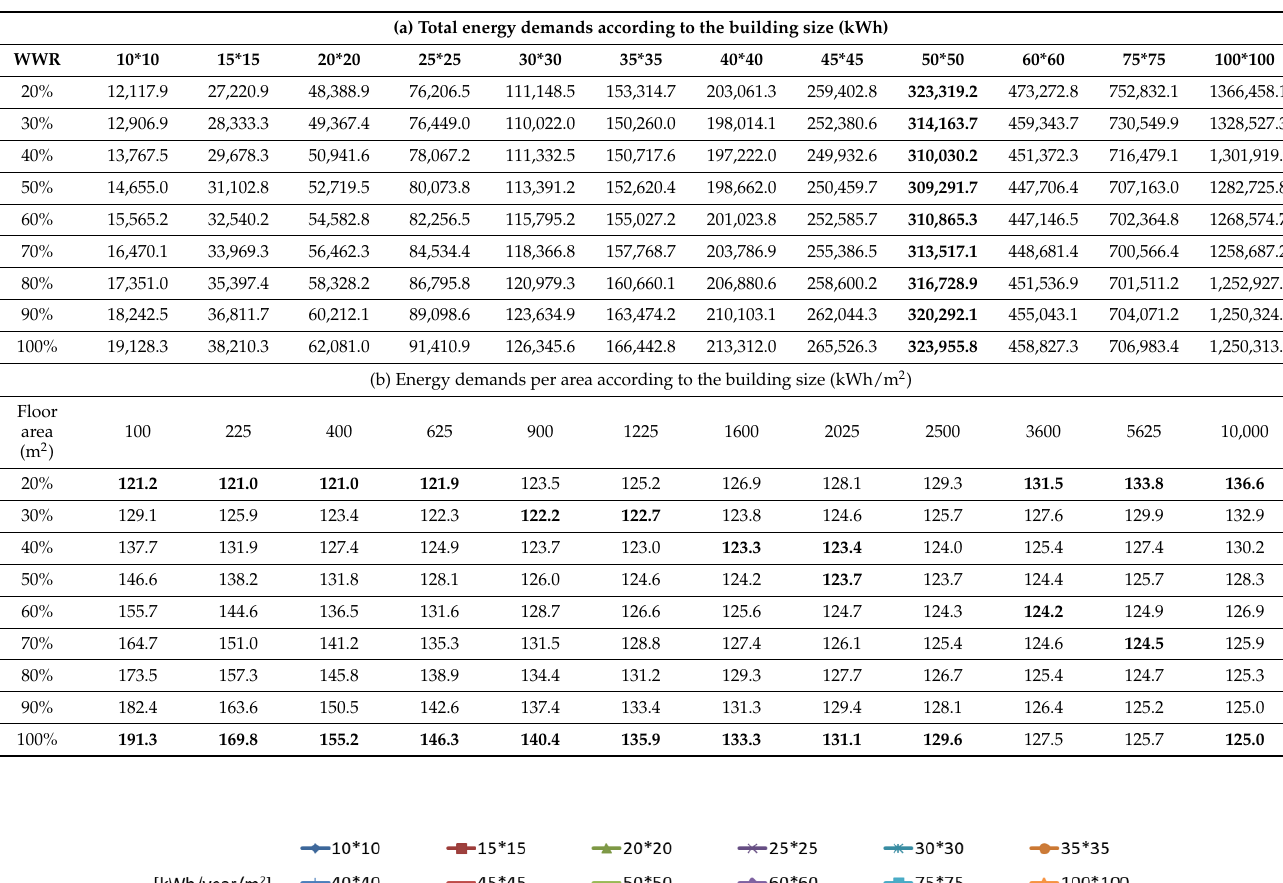
Table 5. Energy demands according to the building size.